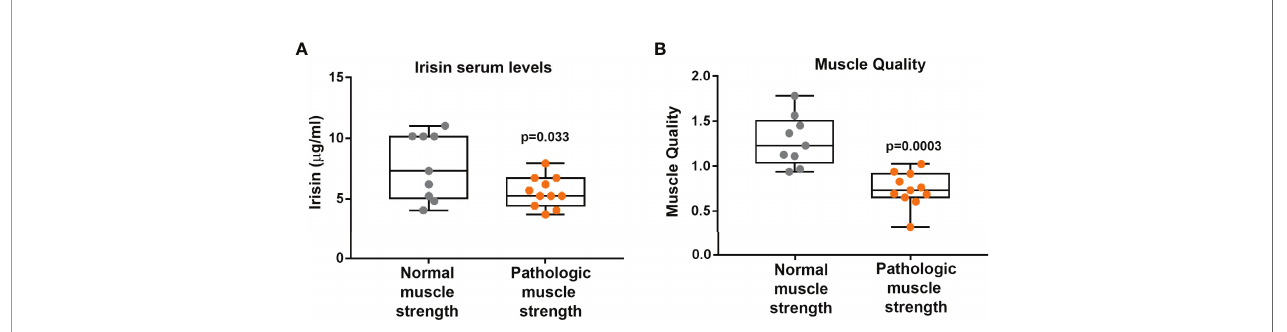
FIGURE 2 | CMT patients with pathological muscle strength (N = 11) show lower Irisin levels than CMT patients with normal muscle strength (N = 9) (A) . Muscle quality is lower in CMT patients with pathological muscle strength (N = 11) than CMT patients with normal muscle strength (N = 9) (B) . Data are presented as box- and-whisker plots with median and interquartile ranges, from max to min, with all data